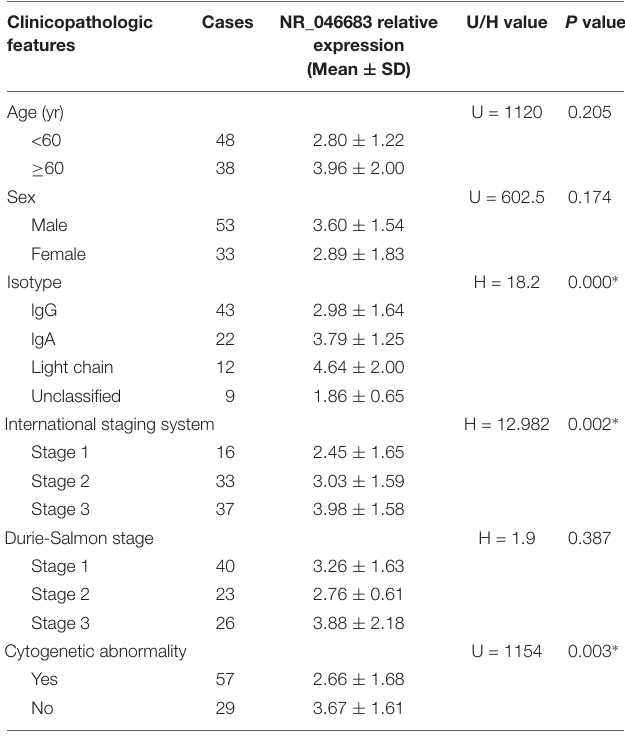
TABLE 3 | Correlations between the relative expression of lncRNA NR_046683 and clinicopathologic features in 86 MM patients. Clinicopathologic